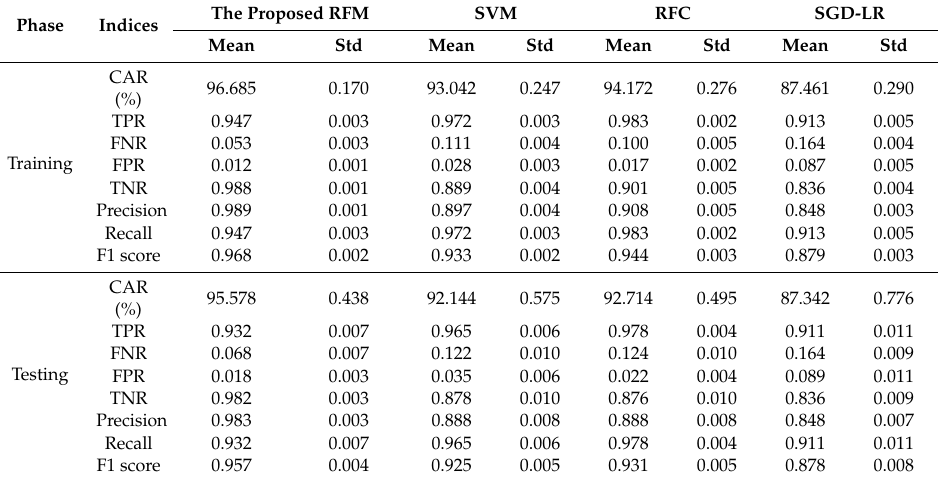
Table 3. Prediction result